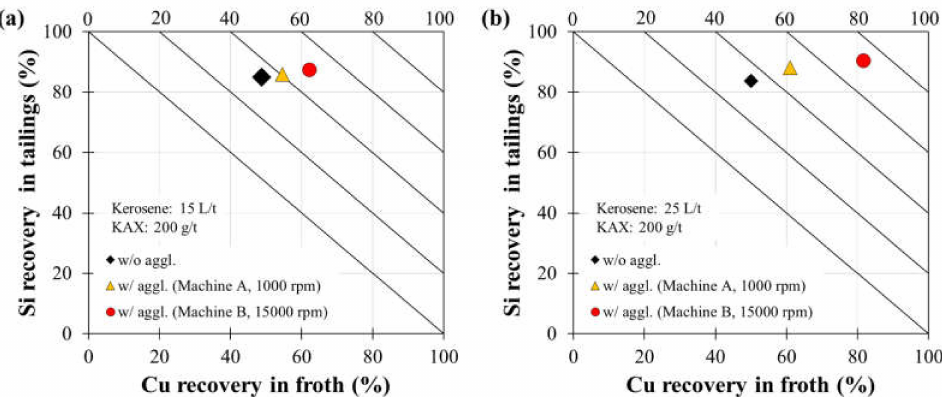
Figure 10. Relationship between Cu recovery in froth, R Cu (%), and Si recovery in tailing, R Si (%), of chalcopyrite and quartz mixture with di ff erent kerosene dosage: ( a ) 15 L kerosene / t sample and ( b ) 25 L kerosene / t